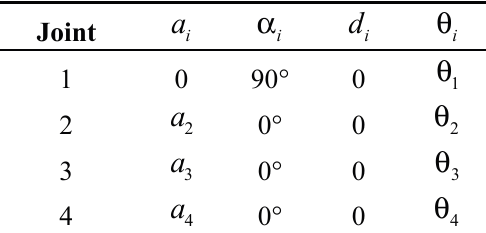
Figure A1. The 4R articulated robot arm analyzed by D-H. Table A1. D-H